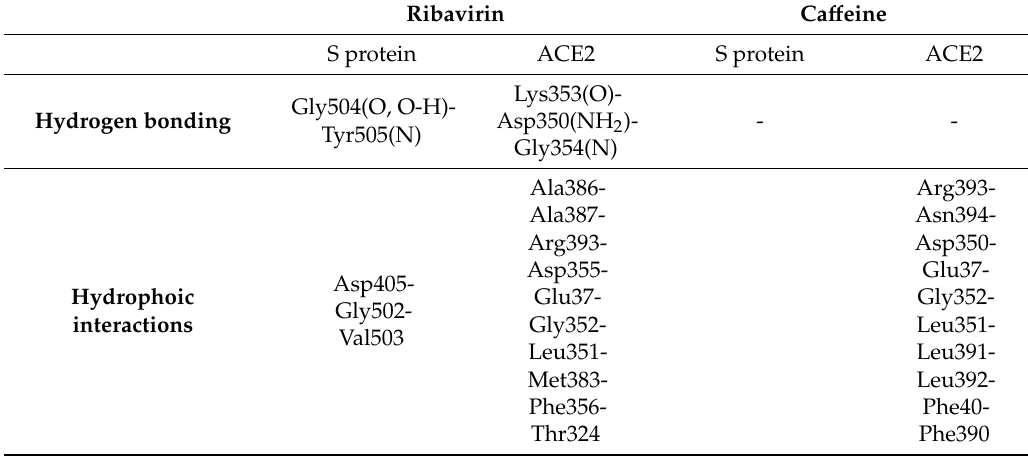
Table 2. Contact residues of the SARS-CoV-2 RBD-ACE2 interfacing with ribavirin and caffeine. Residues involved in the hydrogen and hydrophobic interactions between S protein and ACE2 + ribavirin +